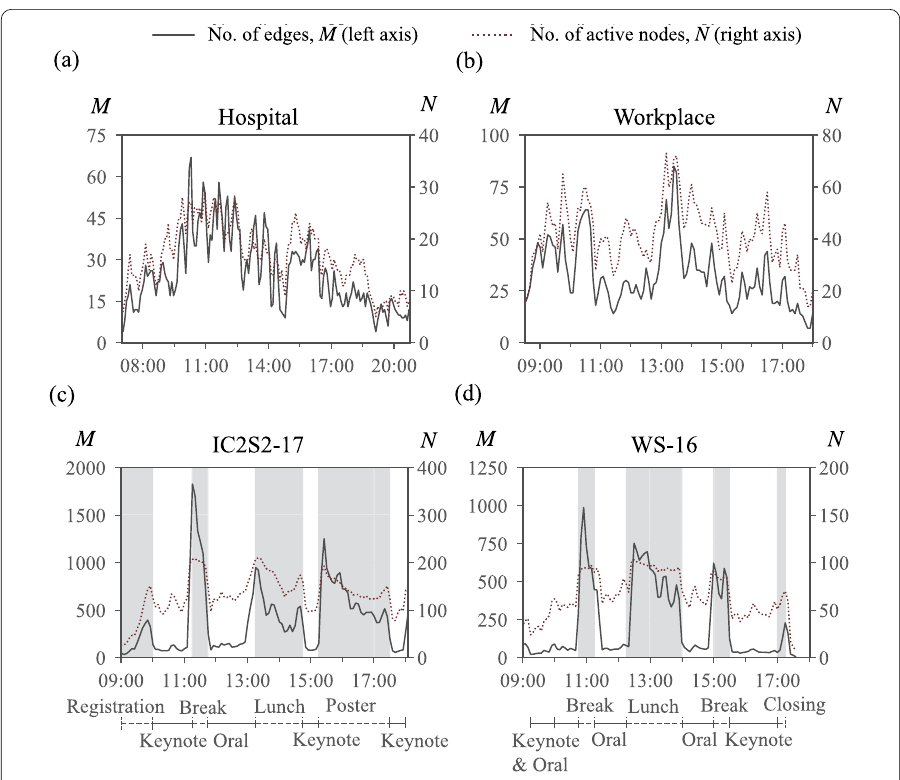
Figure 1 Evolution of number of edges M and active nodes N in face-to-face networks. The following days are shown for each data set: ( a ) Hospital on December 7, 2010, ( b ) Workplace on June 27, 2015, ( c ) IC2S2-17 on July 11, 2017 and ( d ) WS-16 on December 1, 2016. Timeline below panels c and d identify time windows for scheduled events. Gray shading highlights unrestricted sessions i.e., registration, break, lunch, poster session and closing